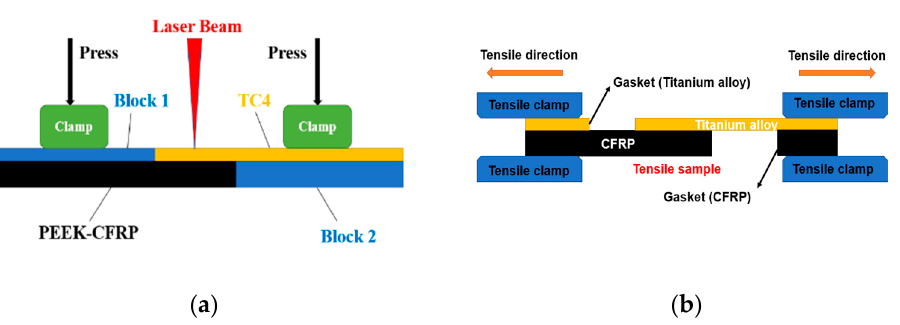
Figure 1. ( a ) Laser lap joining schematic illustration, ( b ) Illustration for the tensile sample in this study. Table 2. Laser welding process parameters.